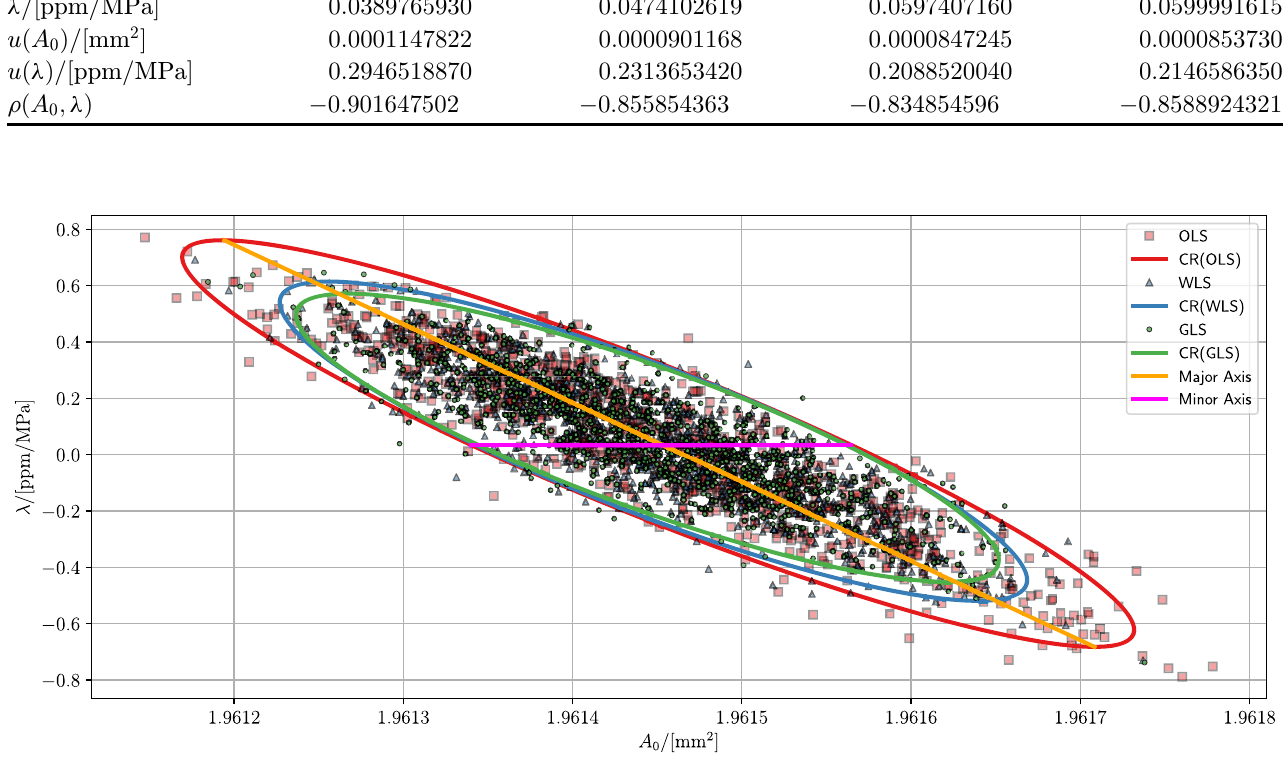
Fig. 3. Comparison of ordinary least squares (OLS), weighted least squares (WLS) and generalized least squares regression analysis from Monte Carlo data. Hyper-ellipsoids are generated to indicate the corresponding 95% con fi dence regions (CRs) and reveals that the highest accuracy scheme is that of a GLS which has the smallest CR which corresponds to a high degree of certainty of the range of possible values, followed by a WLS which has a slightly lower accuracy compared to a GLS, and fi nally a OLS which has the lowest accuracy as the CR is unduly